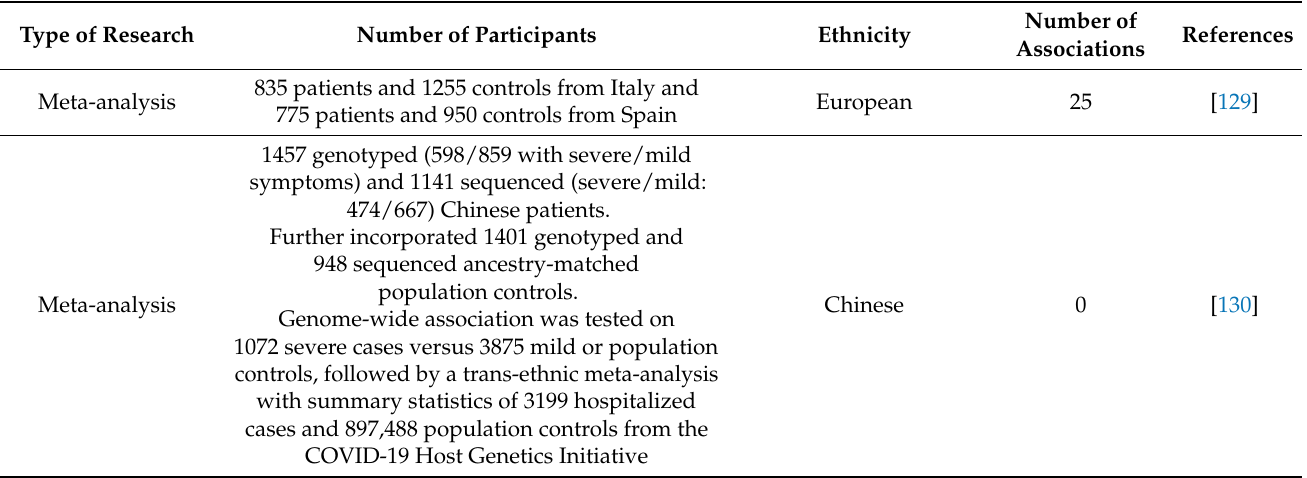
Table 4. Overview of GWAS studies in